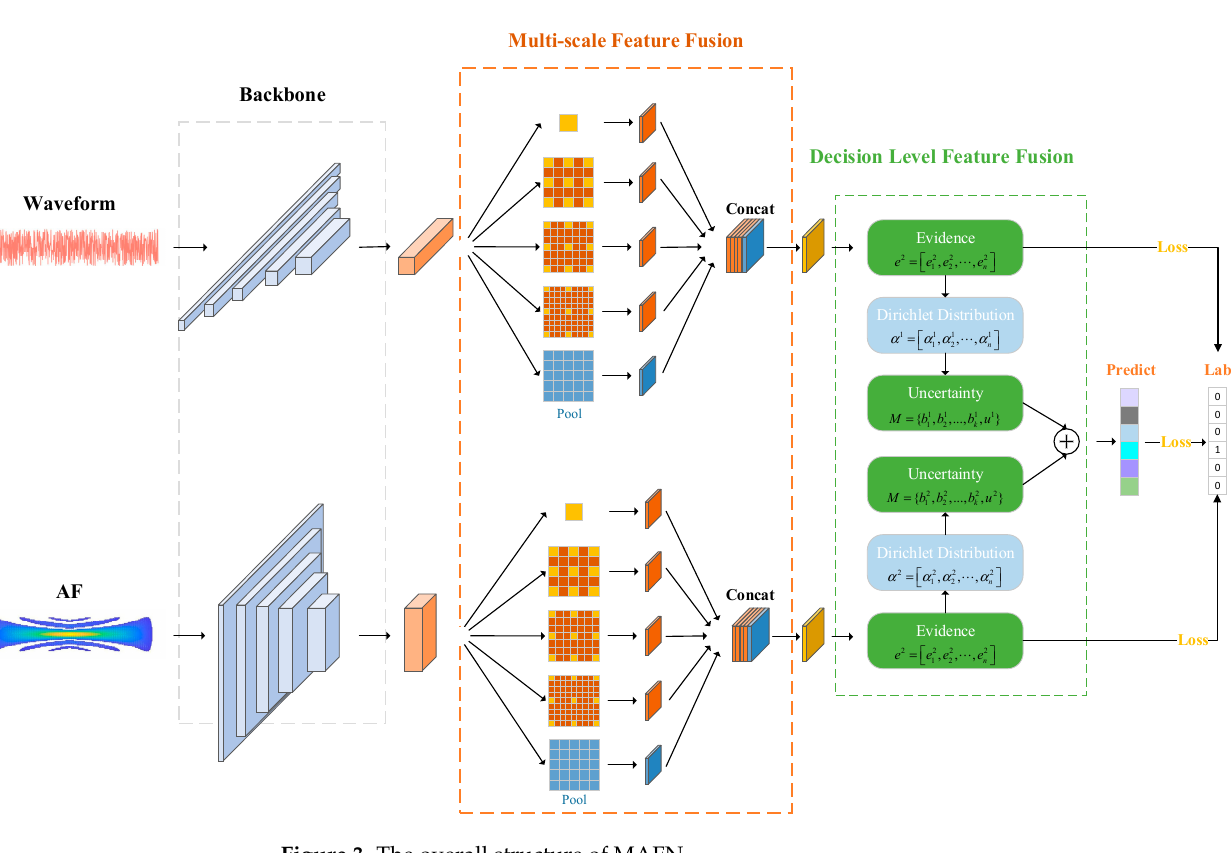
Figure 3. The overall structure of MAFN. Table 1. The parameters of the modified ASPP.